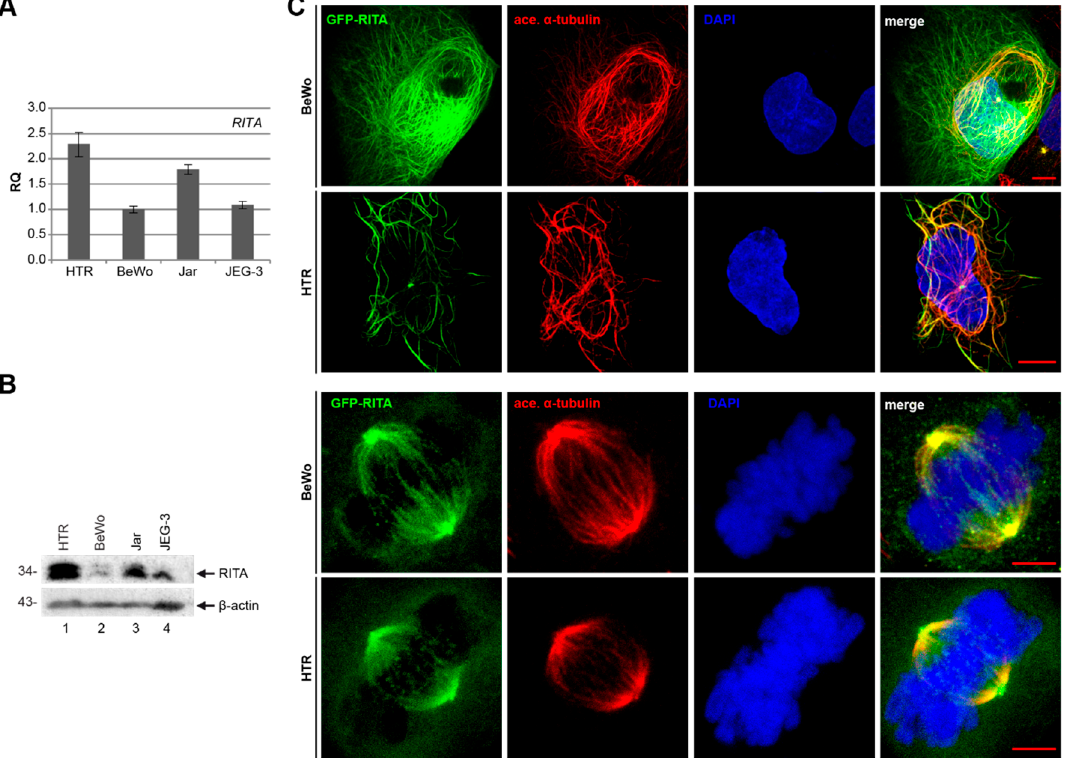
Figure 3. Expression and localization of RITA in various trophoblastic cell lines. ( A ) The relative amount of the gene RITA in diverse trophoblastic cell lines. The results are presented as relative quantification (RQ) with minimum and maximum range, by setting the RITA value of BeWo cells as 1. ( B ) Western blot analysis with cellular extracts from HTR, BeWo, Jar, and JEG-3 using an antibody against RITA. β -actin served as loading control. ( C ) HTR and BeWo cells were transfected with GFP-RITA and stained for the microtubule marker acetylated α -tubulin and DNA (4’,6-diamidino-2-phenylindole-dihydrochloride (DAPI)). Representatives of the subcellular localization of RITA are shown. First and second row scale: 10 µ m, third and fourth row scale: 5 µ